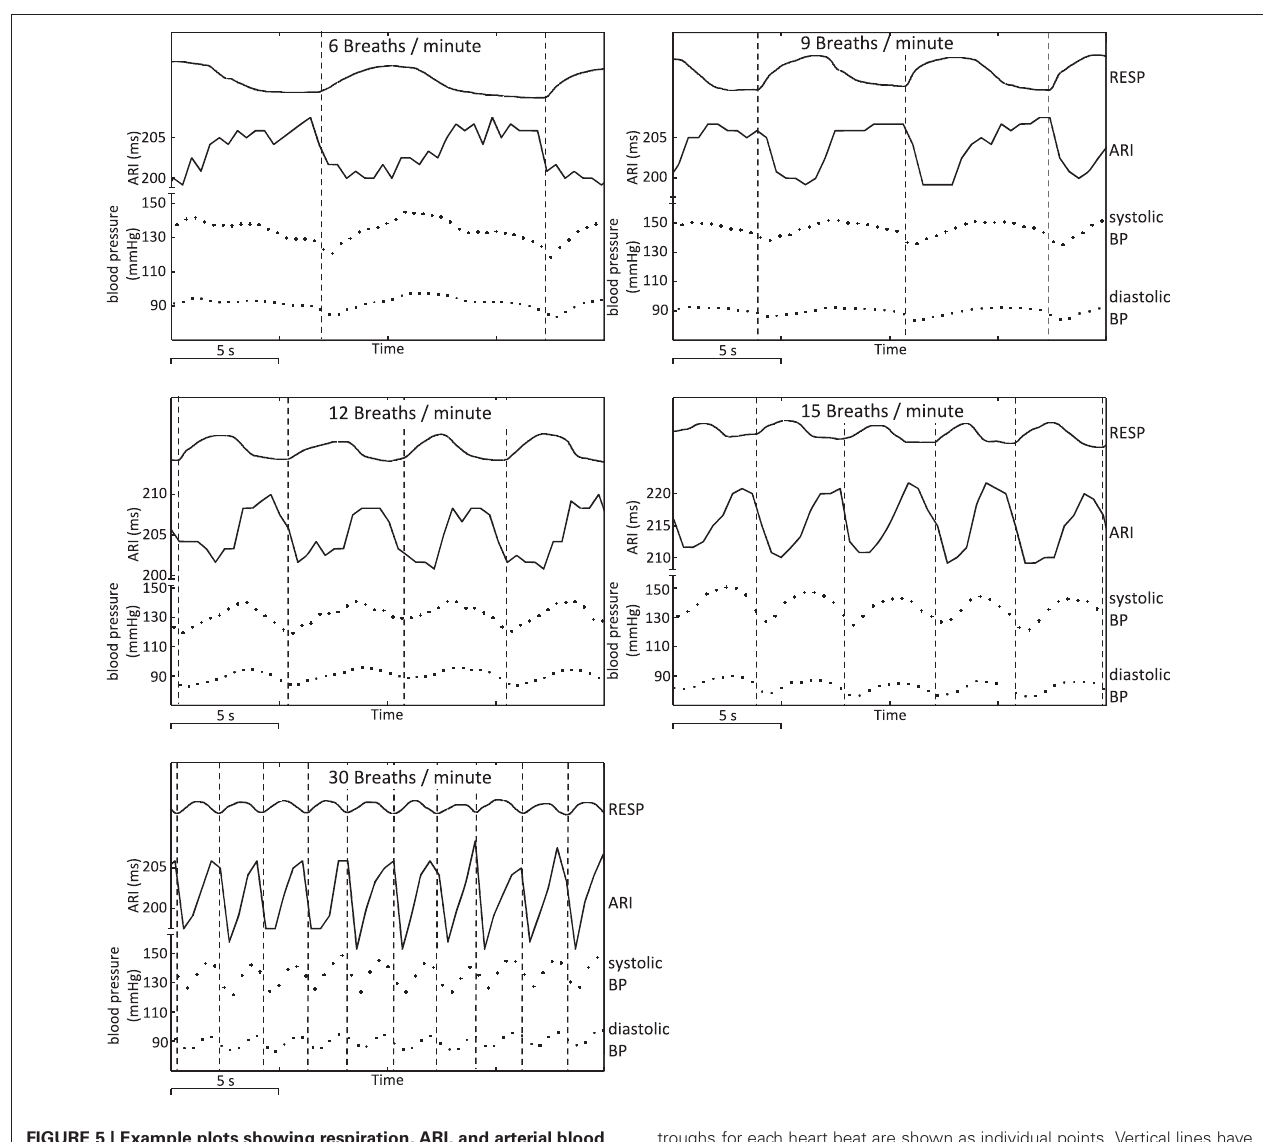
FIGURE 5 | Example plots showing respiration, ARI, and arterial blood pressure at respiratory frequencies of 6, 9, 12, 15, and 30breaths/min, illustrating cyclical variation. Arterial BP: systolic peak values and diastolic